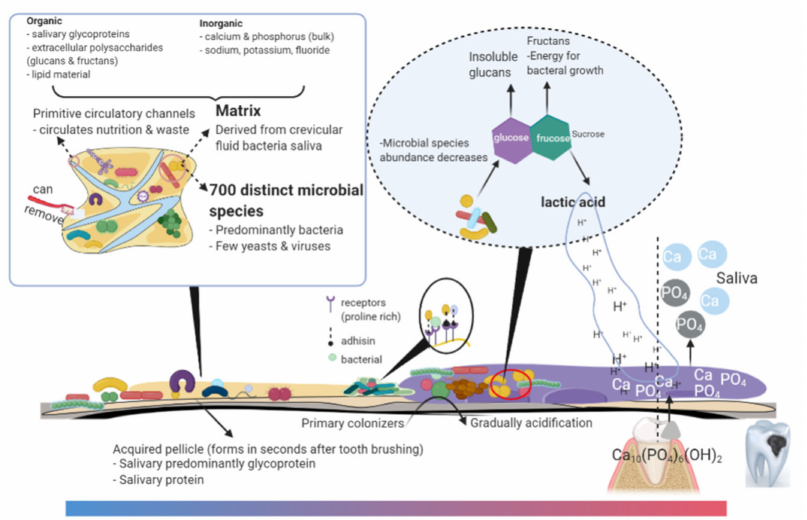
Figure 1. Oral biofilm microenvironment and the trigger of their cariogenicity. Biofilms are present throughout the surface of teeth with a high level of spatial matrix organization and up to 700 distinct microbial species or phylotypes. Primary colonization of microbes on the tooth surface relies on the acquired pellicle and co-adherence with other oral commensals. The ability of microbes to convert sugars into acids is a potent driver for oral biofilms developing into cariogenic biofilms. The acidification of the environment leads to the release of calcium and phosphates into saliva. The illustration was created with